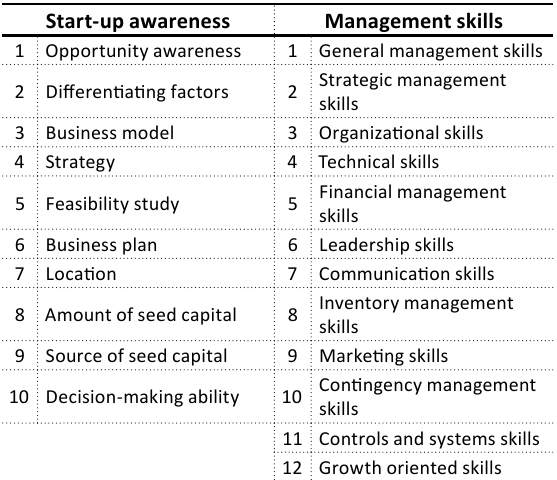
Table 1. Determinants of start-up business success